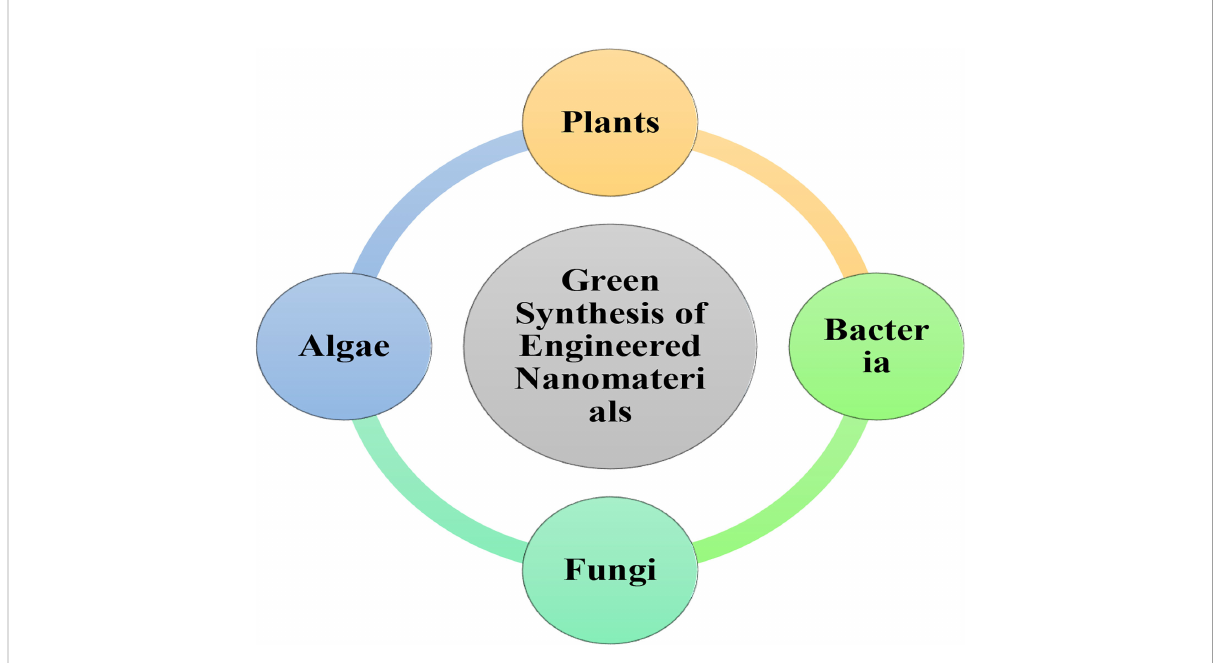
FIGURE 1 Biosynthesis routes of engineered nonmaterial by different organisms.